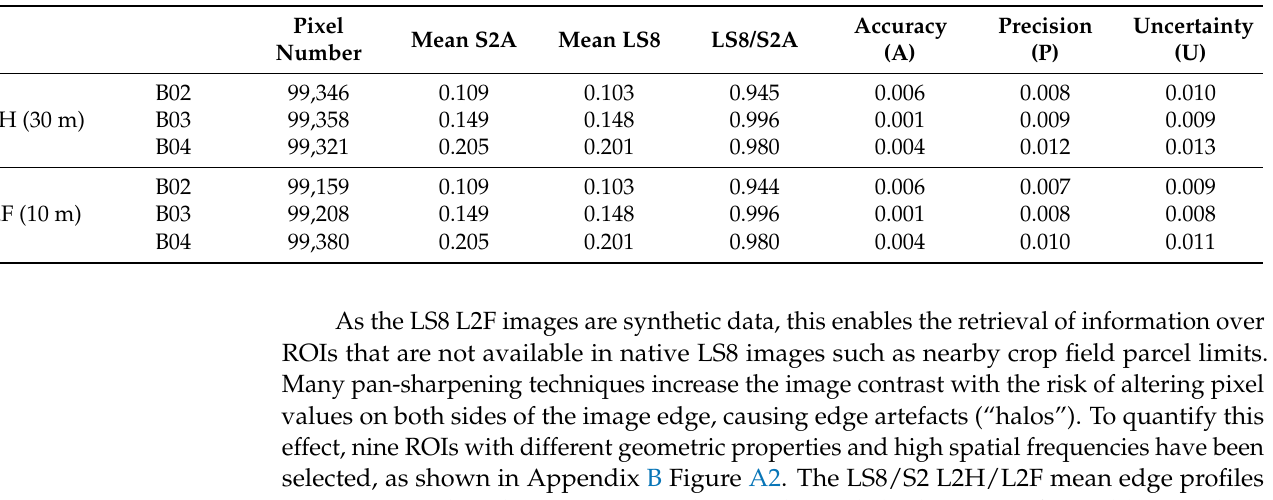
Table 5. Validation of S2L fusion algorithms, image comparison between LS8 L2H, LS8 L2F and S2A image (as reference) dated 14 July 2019, tile 12SVB).